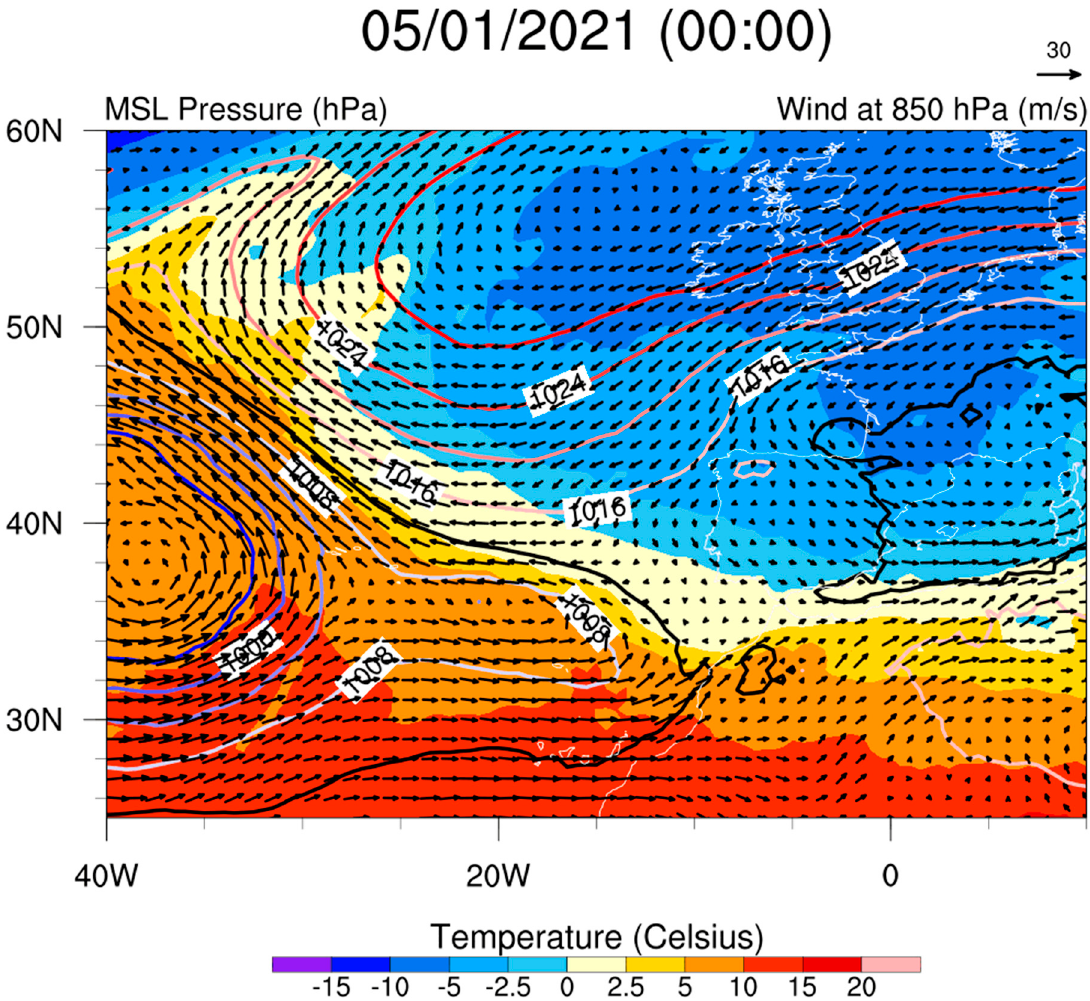
Figure 1. ECMWF analysis, depicting the evolution of the surface pressure, the 850 hPa temperature and the 850 hPa wind from Jan 5th to 10th. Original raw data (grib files) from the ECMWF. Processing and graphics done at UCLM. [The sequence of events can be found in animated format. If reading a static version of this text please see the animated figure in the supplementary information].